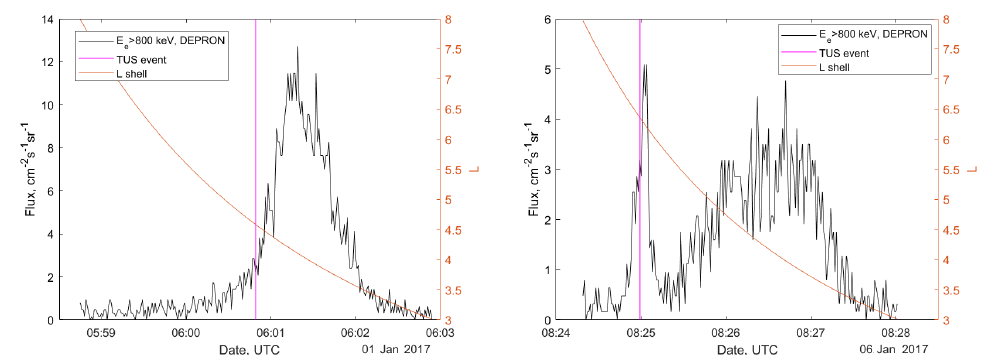
Figure 2. DEPRON measurements data during two TUS events: 1 January 2017, 06:00:49 UTC;